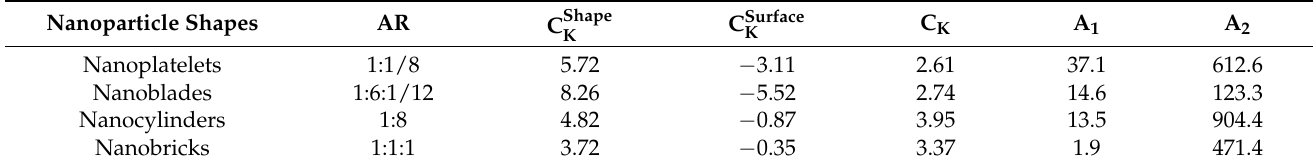
Table 2. Coefficients of thermal conductivity and dynamic viscosity of different nanoparticle shapes [37]. Nanoparticle